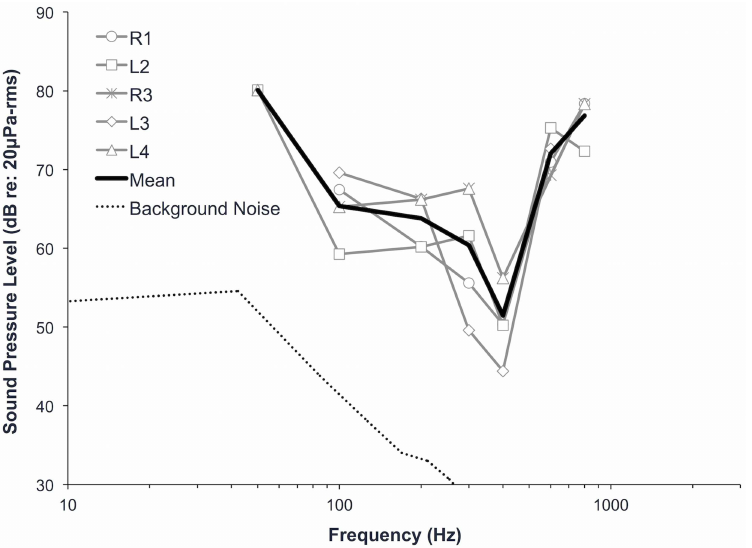
Fig 5. Aerial audiograms for juvenile green sea turtles ( Chelonia mydas ). Spectrum level background noise is represented the dotted line (dB re: 20 μ Pa/